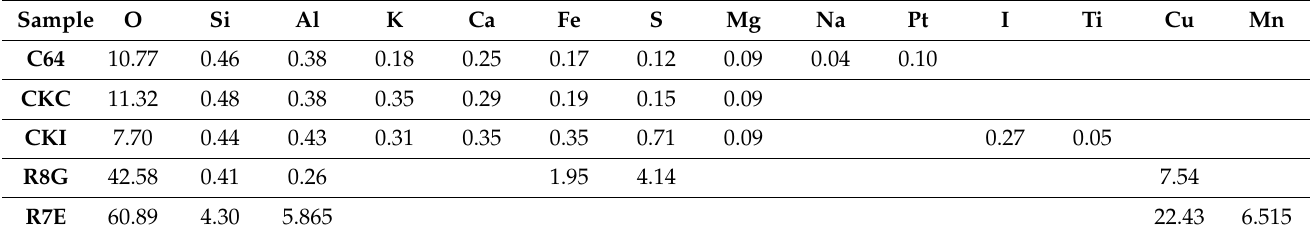
Table 3. Atomic concentration percentage composition of the samples